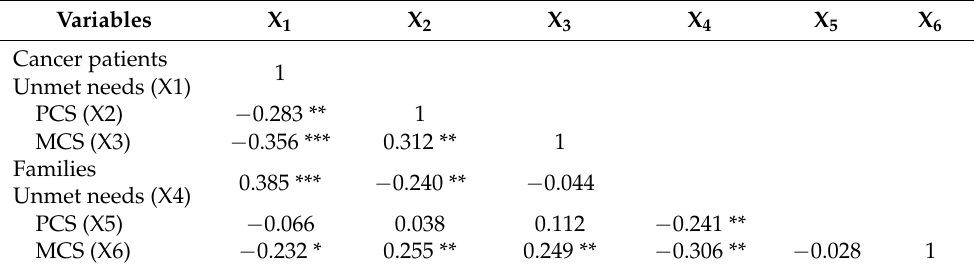
Table 5. The absolute values of correlation coefficients were between 0.03 and 0.39, thus confirming the absence of a multicollinearity issue. Table 5. Correlations among the measured